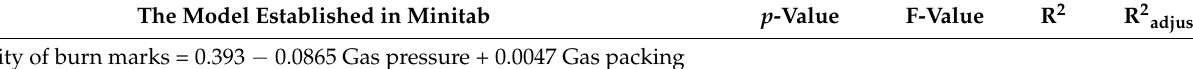
Table 4. Regression model between gas parameters and burn marks.